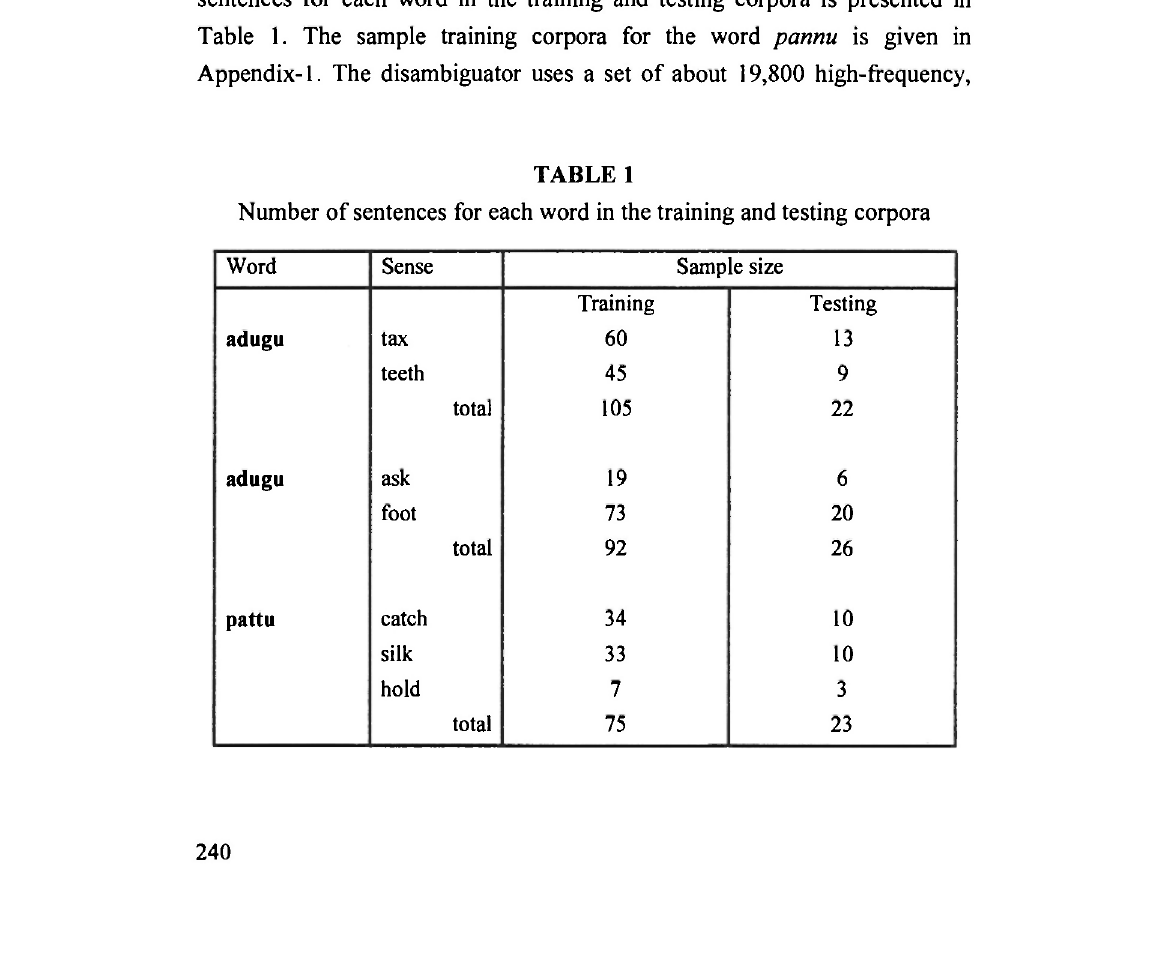
Table 1. The sample training corpora for the word pannu is given in